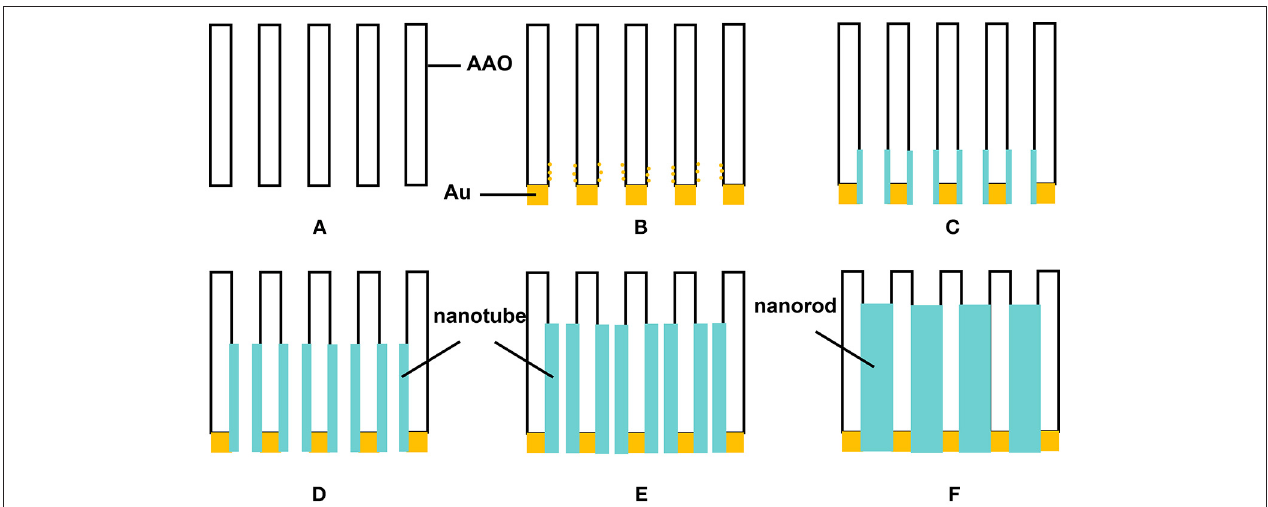
FIGURE 2 | Schematic diagram of the growth of alloy nanotubes. (A) section of AAO template, (B) section after spraying gold, (C–F) deposition process in template.